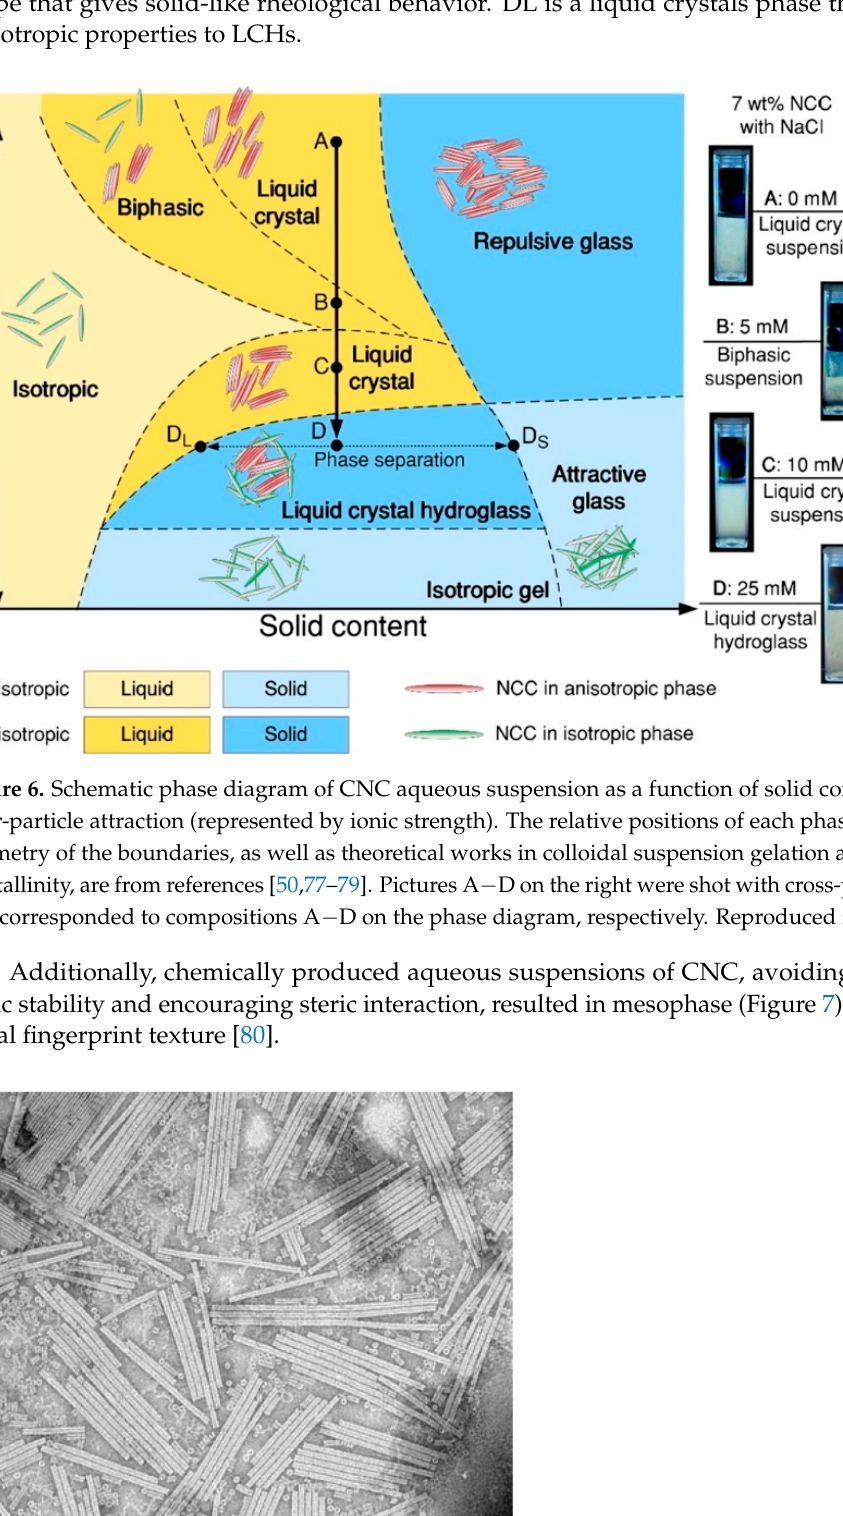
spinodal breakdown (and subsequent gelation) coinciding with an anisotropic liquid